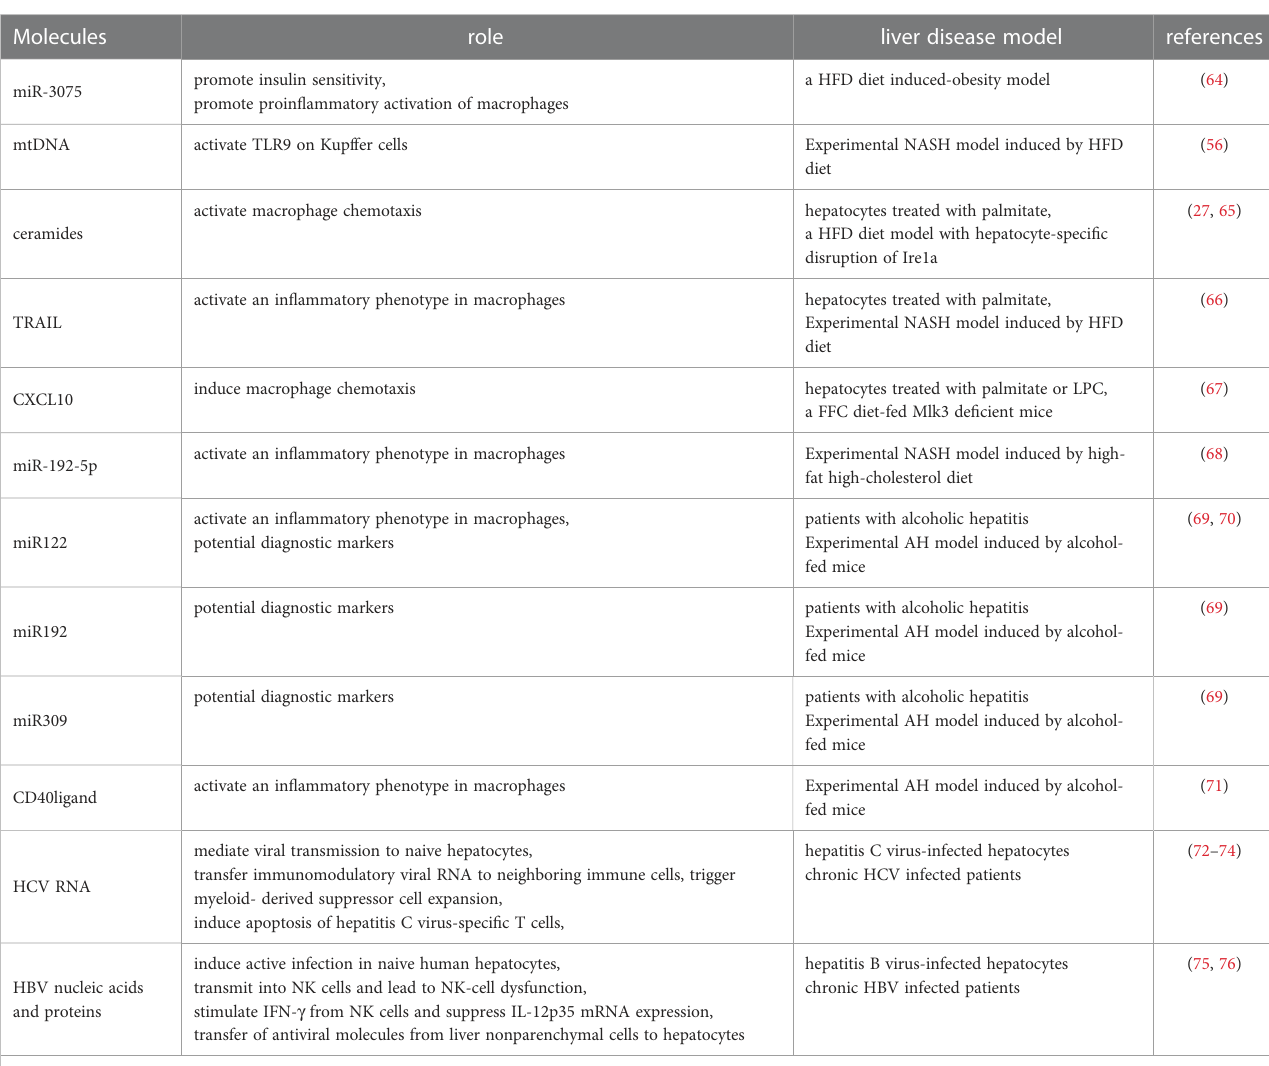
TABLE 1 Biosynthesis of secreted extracellular vesicles by hepatocytes.